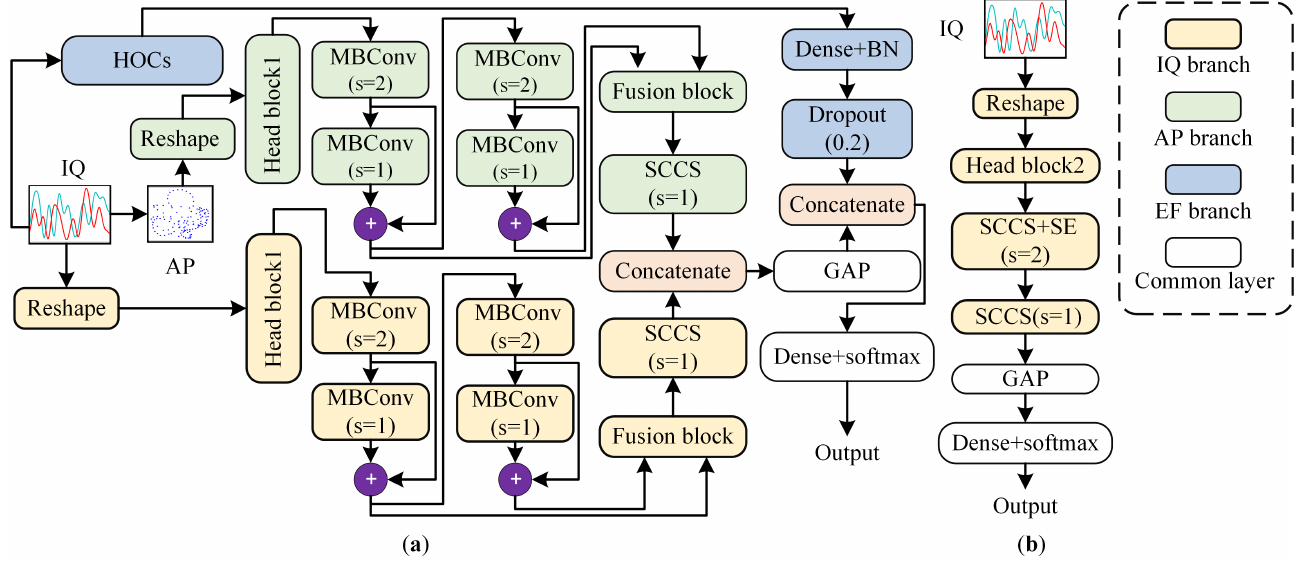
Figure 2. Overall structure of proposed ( a ) LENet-L and ( b )